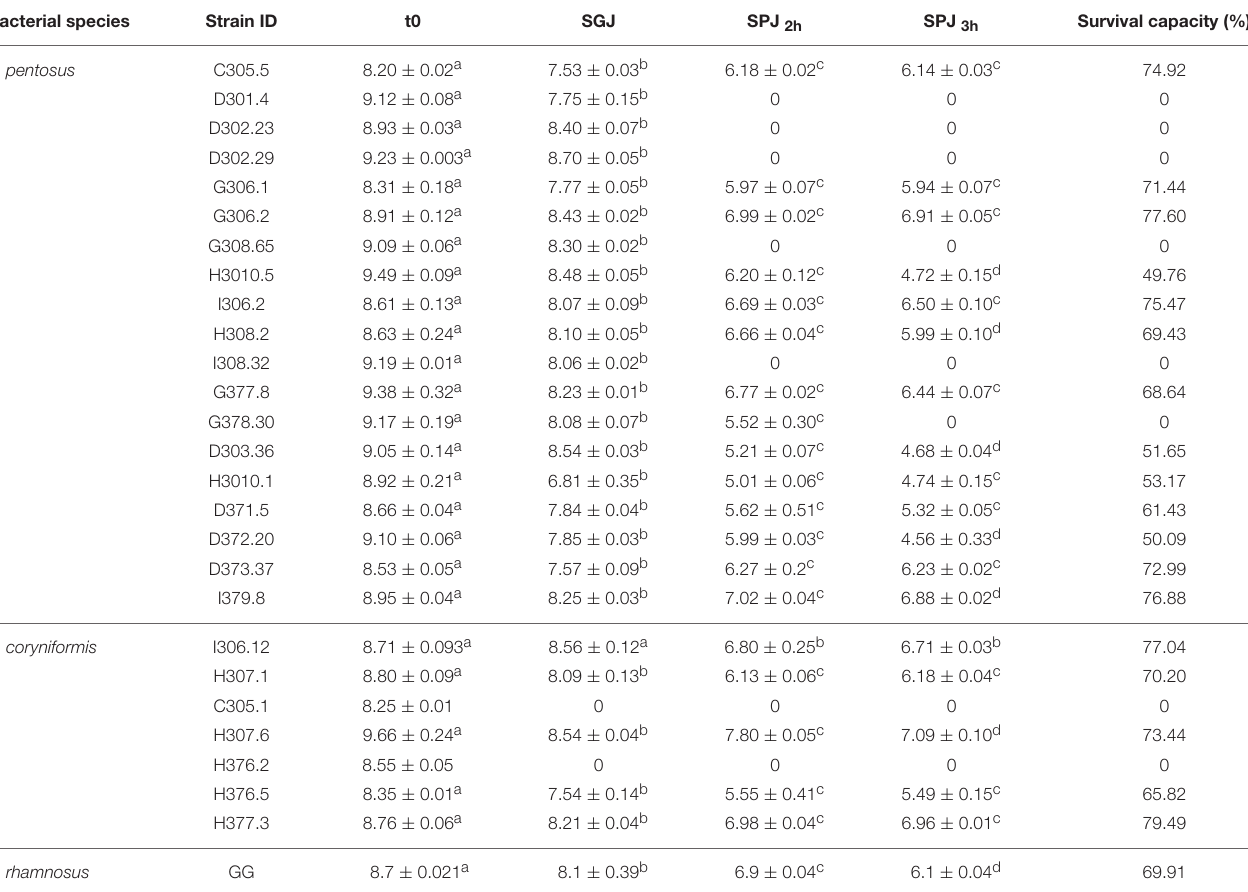
TABLE 2 | Survival of L. pentosus and L. coryniformis strains under in vitro simulated gastro-intestinal conditions. Bacterial species Strain ID t0 SGJ SPJ 2h SPJ 3h Survival capacity (%) L.